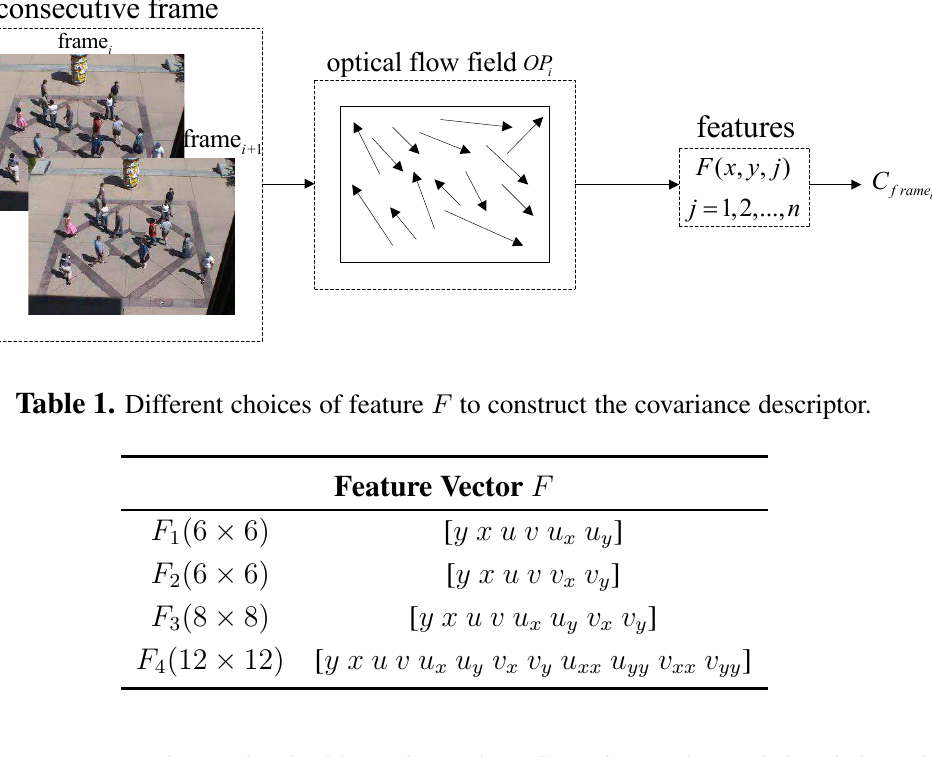
Figure 2. Covariance descriptor computation based on the features of a video frame.